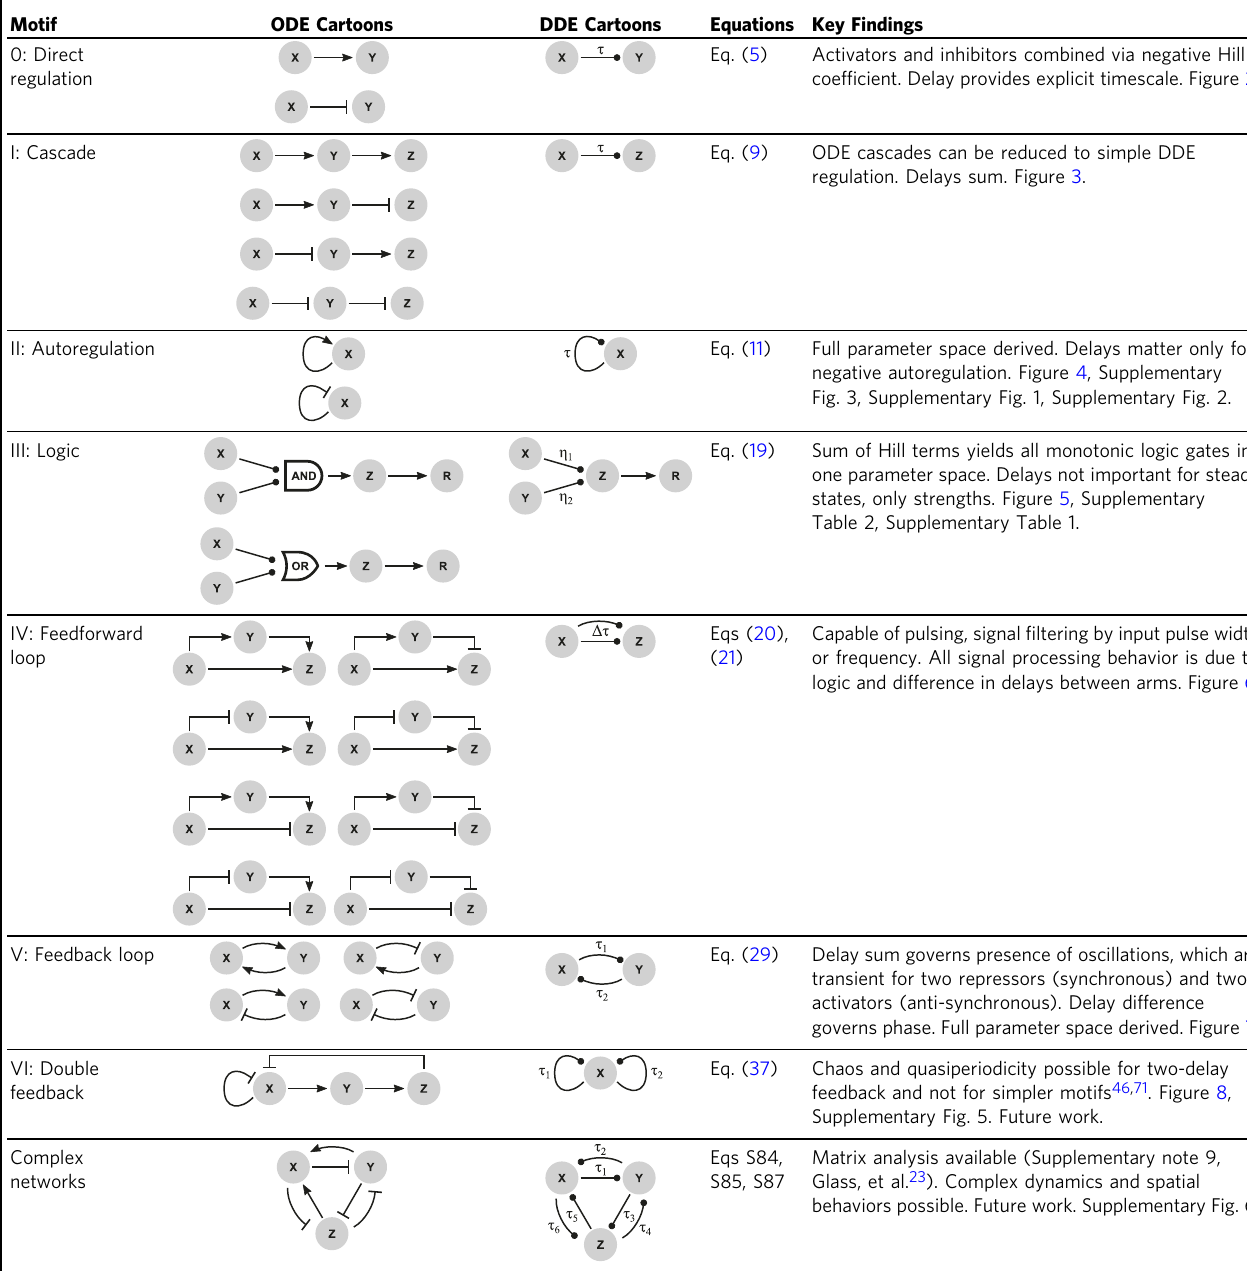
Supplementary Fig. 5. Future